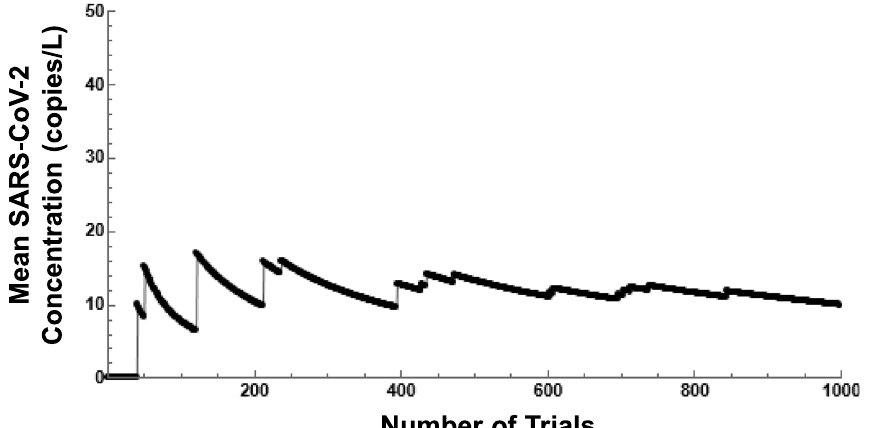
Fig. 4 Simulation output, running mean SARS-CoV-2 concentration (L/s), 1000